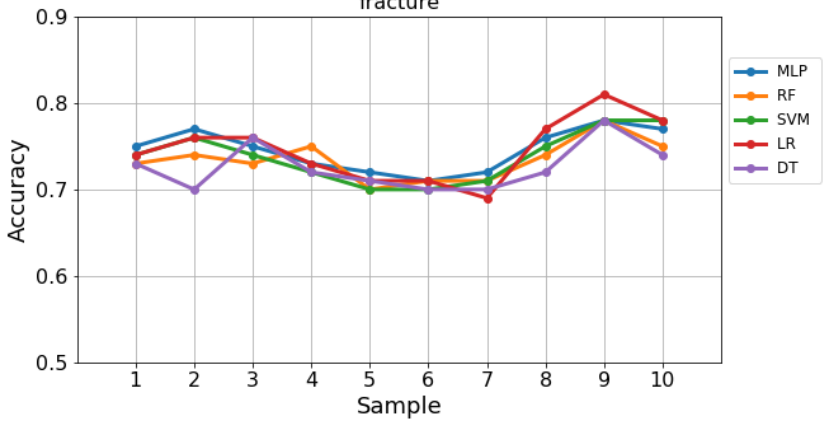
Figure 6. The score of five models across 10 validation samples on the fracture